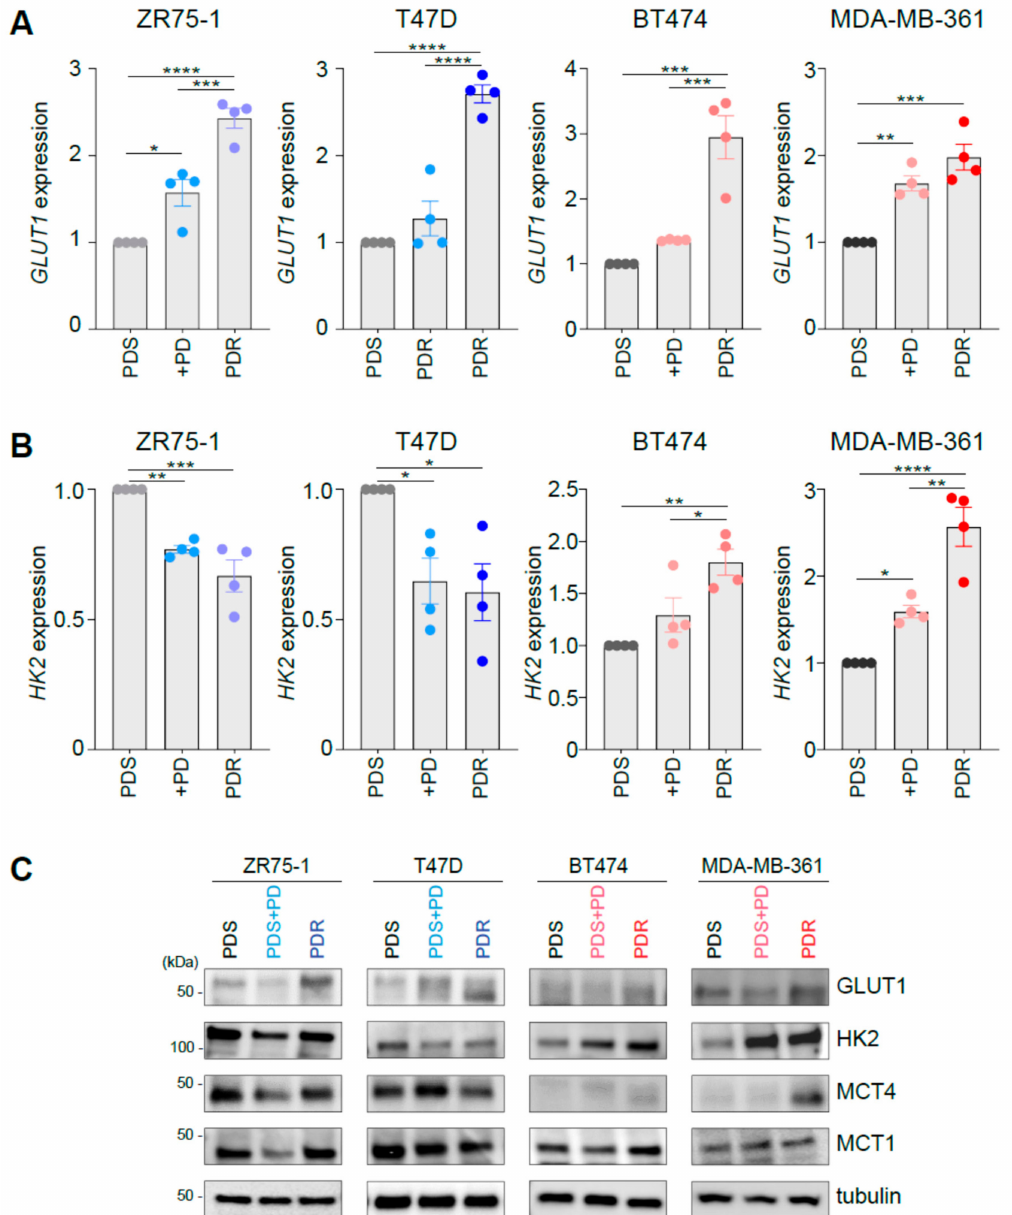
Figure 1. Palbociclib impacts on the expression of key players involved in glucose catabolism. ( A , B ) Palbociclib-resistant (PDR) and parental sensitive (PDS) cells, in presence or absence of 1 µ M palbociclib (PD), were subjected to quantitative real-time polymerase chain reaction (qRT-PCR) analysis using the assays described in the figure. Relative expression is shown using the PDS cells as comparator. Each dot represents a biological replicate. Gray shades are used for PDS cells, blue shades when PD is administrated to human epidermal growth factor receptor 2 (HER2 − ) cells (either PDS or PDR), red shades when PD is administrated to HER2 + cells (either PDS or PDR). Data represent means ± standard errors of the mean (SEMs). One-way analysis of variance (ANOVA); Bonferroni corrected; * p < 0.05; ** p < 0.01; *** p < 0.001; **** p < 0.0001. ( C ) Total protein lysates from PDS (either in the presence or absence of 1 µ M palbociclib, PD) and PDR cells were subjected to Western blot analysis, as